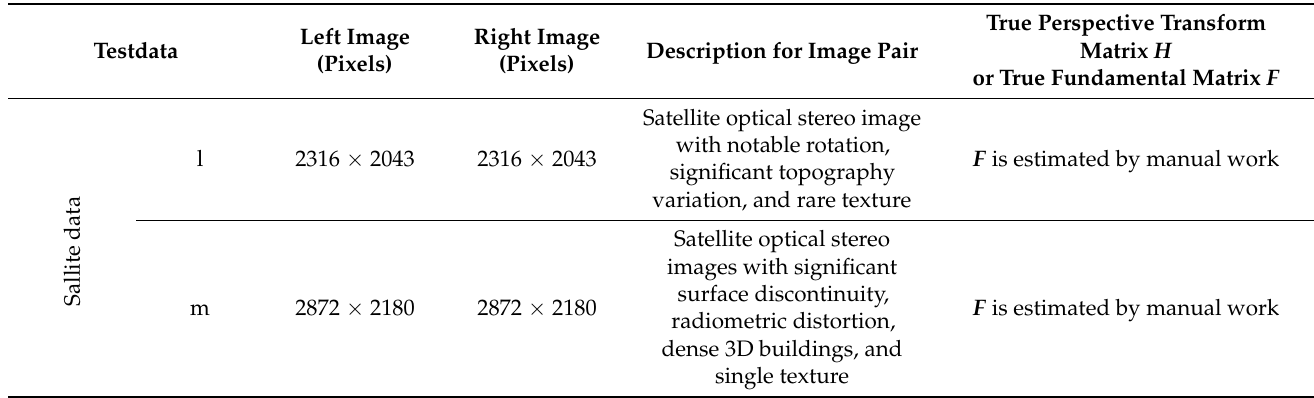
Table 3. The contrast of ten algorithms in the aspect of number of matches. Bold font denotes the best results.